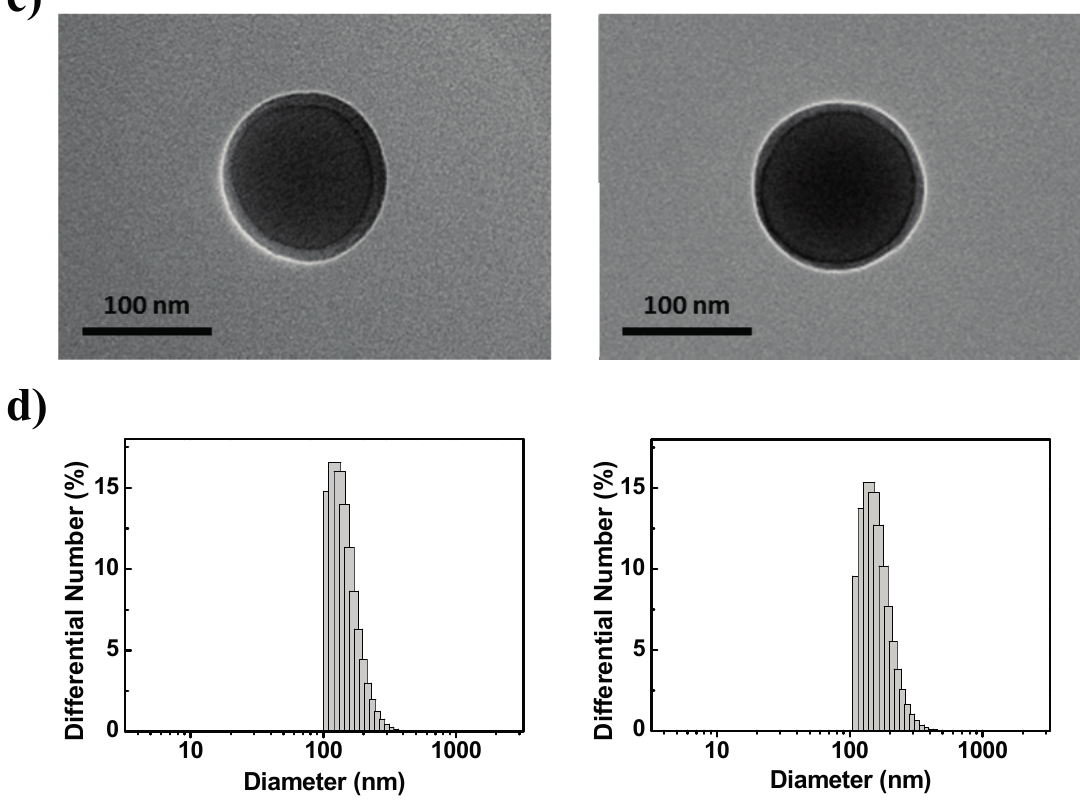
Figure 1. ( a ) Schematic illustration for the fabrication of autofluorescent nanocomposites based on electrostatic assembly and cross-linking by glutaraldehyde; ( b ) Chemical structure of cross-linked amino groups by glutaraldehyde monomer (PLL: ① , Chitosan: ③ ) and polymerized glutaraldehyde (PLL: ② , Chitosan: ④ ); ( c ) TEM images of γ -PGA/PLL (left) and γ -PGA/Chitosan (right) nanocomposites, respectively; ( d ) DLS analysis of γ -PGA/PLL (left) and γ -PGA/Chitosan (right) nanocomposites,